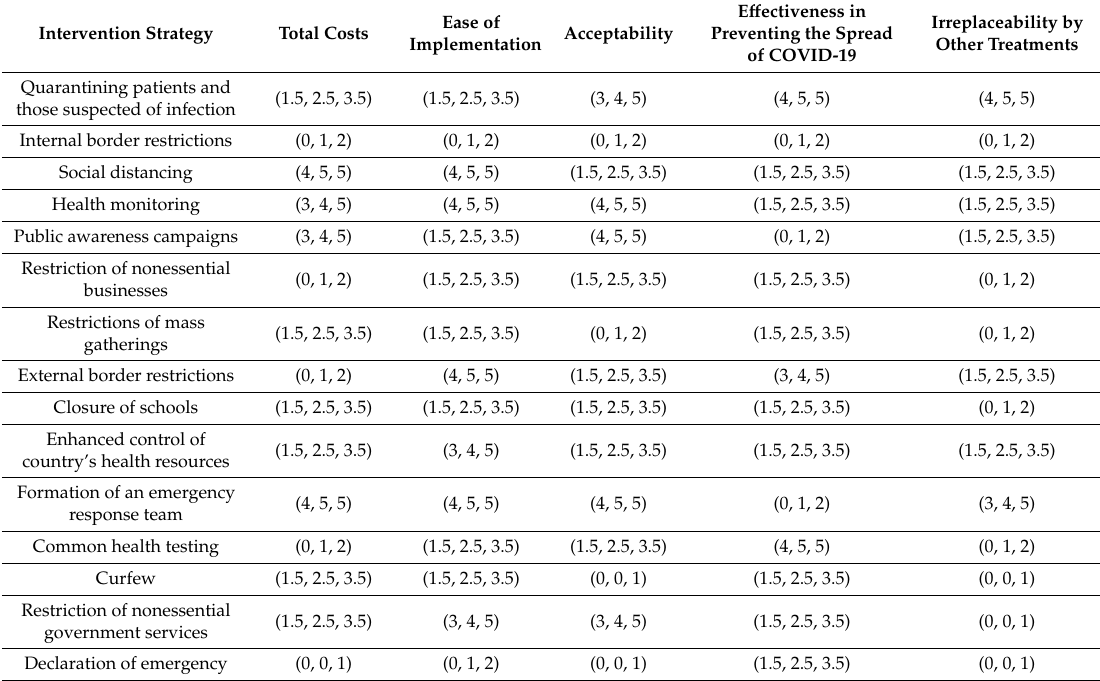
Table 7. Evaluation